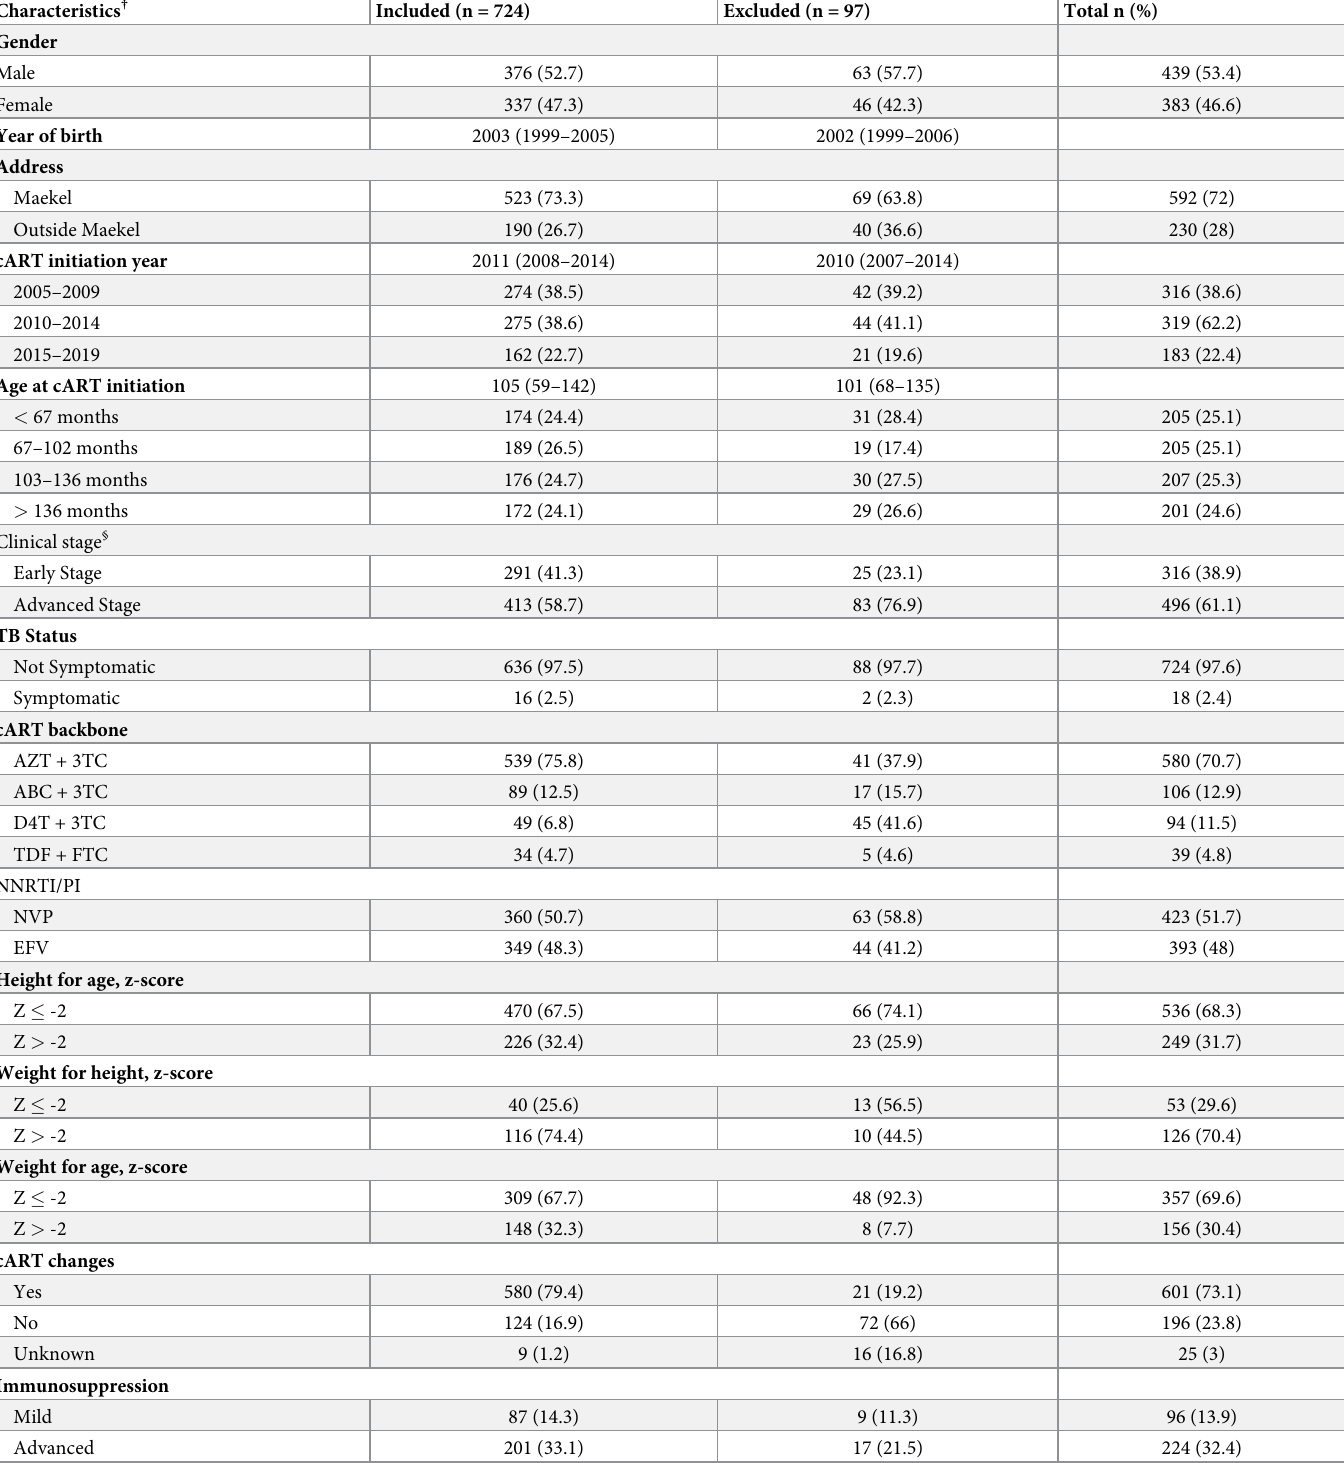
Table 1. Baseline characteristics of HIV-infected children and adolescents in the in National Referral Pediatric Follow-up Clinic, Asmara, Eritrea